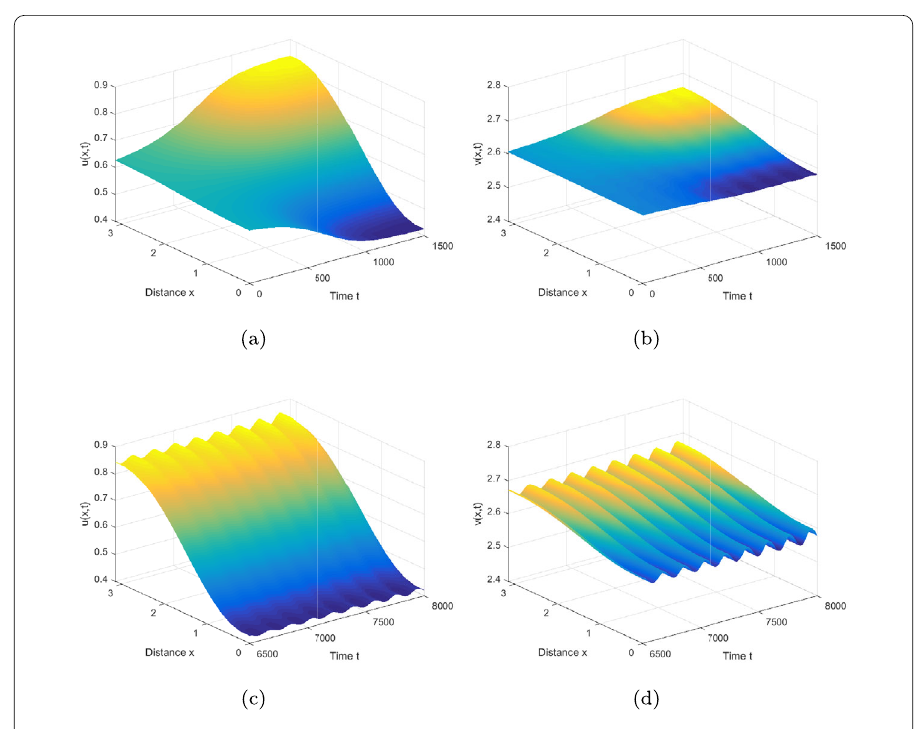
Figure 6 When ( μ 1 , μ 2 ) = (0.1,0.005) lies in region ④ , system (23) has an unstable constant steady state E 4 (0.6115,2.6044) and a stable spatially inhomogeneous periodic solution, where u ( x ,0) = 0.6115– 0.015cos x , v ( x ,0) = 2.6044–0.001cos x . The simulate time is from 0 to 1500 in ( a ) and ( b ) and the simulate time is from 6500 to 8000 in ( c ) and ( d )